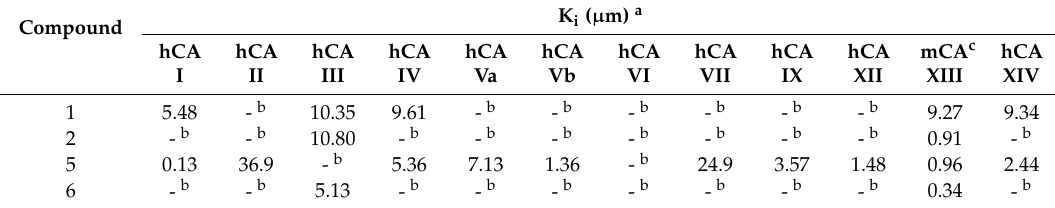
Figure 3. ( A ) Dodoneine 1 , its analogue 2 , and xylariamide A 4 ; ( B ) Active site view of hCA II/ 4 adduct (Protein Data Bank (PDB) code 3P4V) showing residues participating in the recognition of the inhibitor molecule. Only one conformation of the chlorophenol moiety is reported. Water molecules are shown as red circles. Table 1. Human Carbonic Anhydrase inhibition data of dodoneine and its analogues (stopped flow CO 2 hydrase assay)